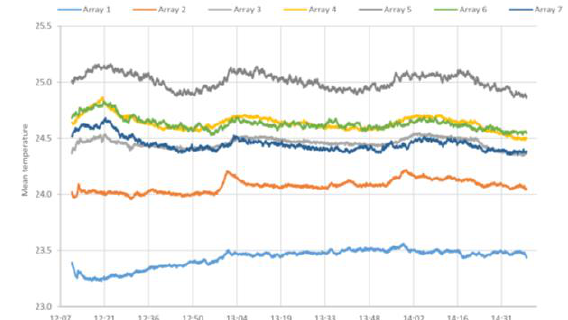
Figure 5. An example thermal trace showing the mean temperature of each thermocouple array over time with the temperature gradually increasing to roof height. Array 5 has the highest temperature values, whilst Array 1 has the